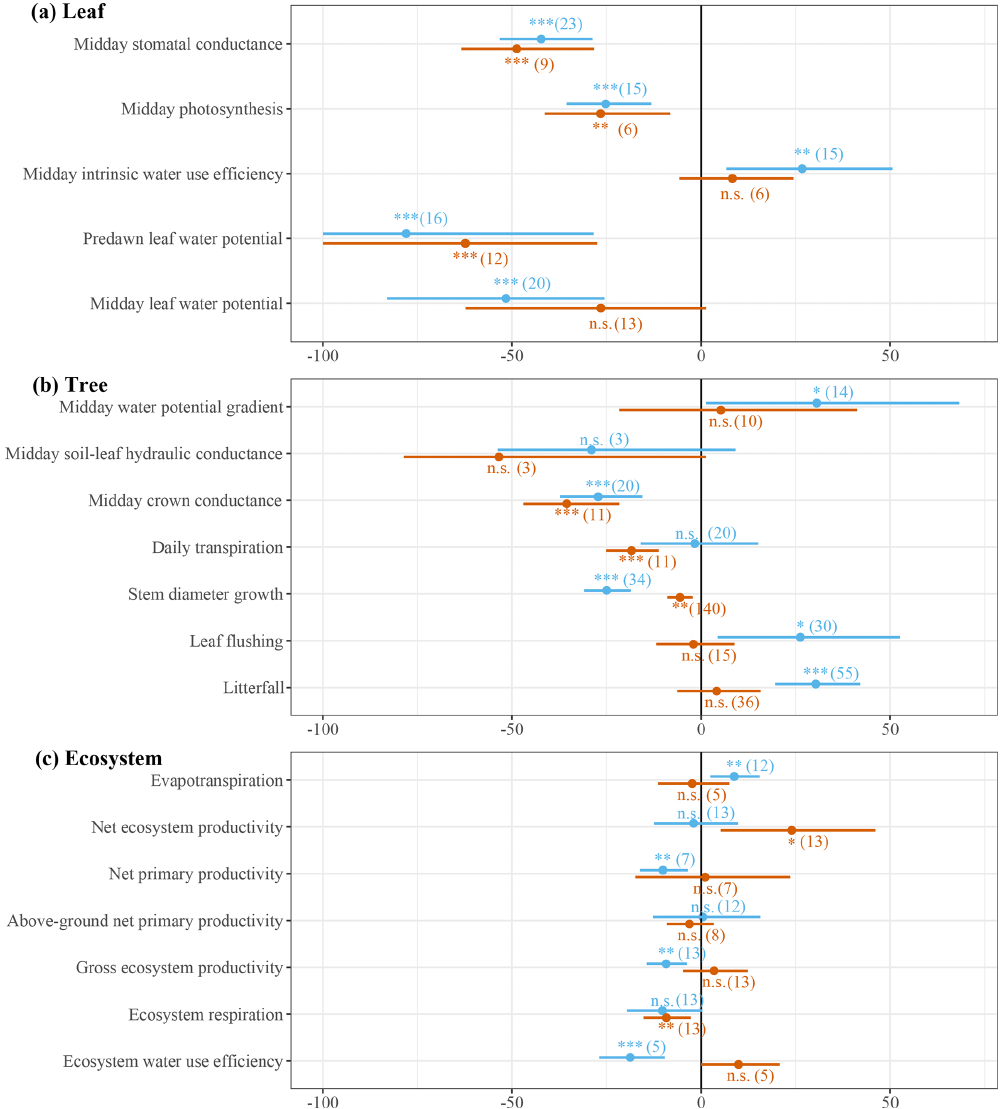
Figure 3. Meta-analysis results of leaf-, tree- and ecosystem-scale responses to seasonal (blue) and episodic (red) drought. The dots are the averages and the horizontal lines represent 95% confidence intervals of percentage change in leaf-, tree- and ecosystem-scale performance. The confidence intervals for predawn leaf water potential were cut off at − 100% to prevent the x axis from inflating. Repeated measurements were used; therefore the variance of the response ratio is adjusted for by the correlation coefficient between the repeated measurements (Lajeunesse, 2011). The number of consulted studies or sites is provided in brackets. The significance symbols depict the p value derived from a random-effects model ( ∗∗∗ p< 0 . 001; ∗∗ p< 0 . 01; ∗ p< 0 . 05) testing whether the effect size differs significantly from